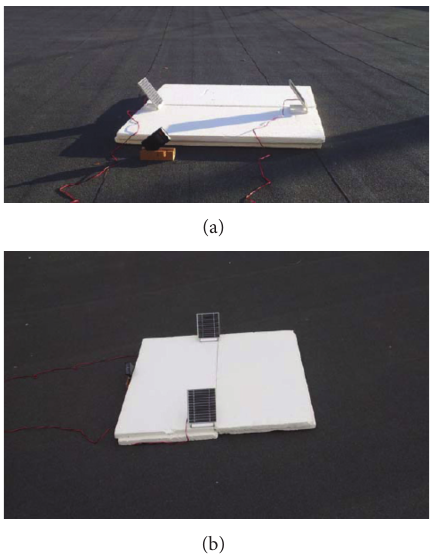
Figure 1: The photovoltaic panels positioning. (a) On a clear day; (b) on a cloudy